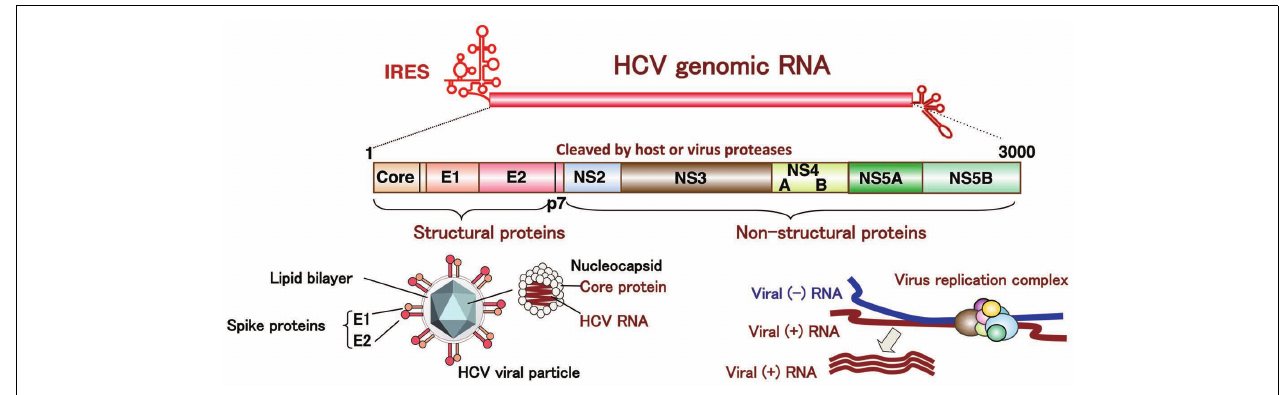
FIGURE 1 | Structure of HCV. HCV RNA encodes a polyprotein composed of about 3,000 amino acids.The core protein, and two envelope proteins are classified as structural protein, while NS2, NS3, NS4A, NS4B, NS5A, and NS5B are non-structural proteins.